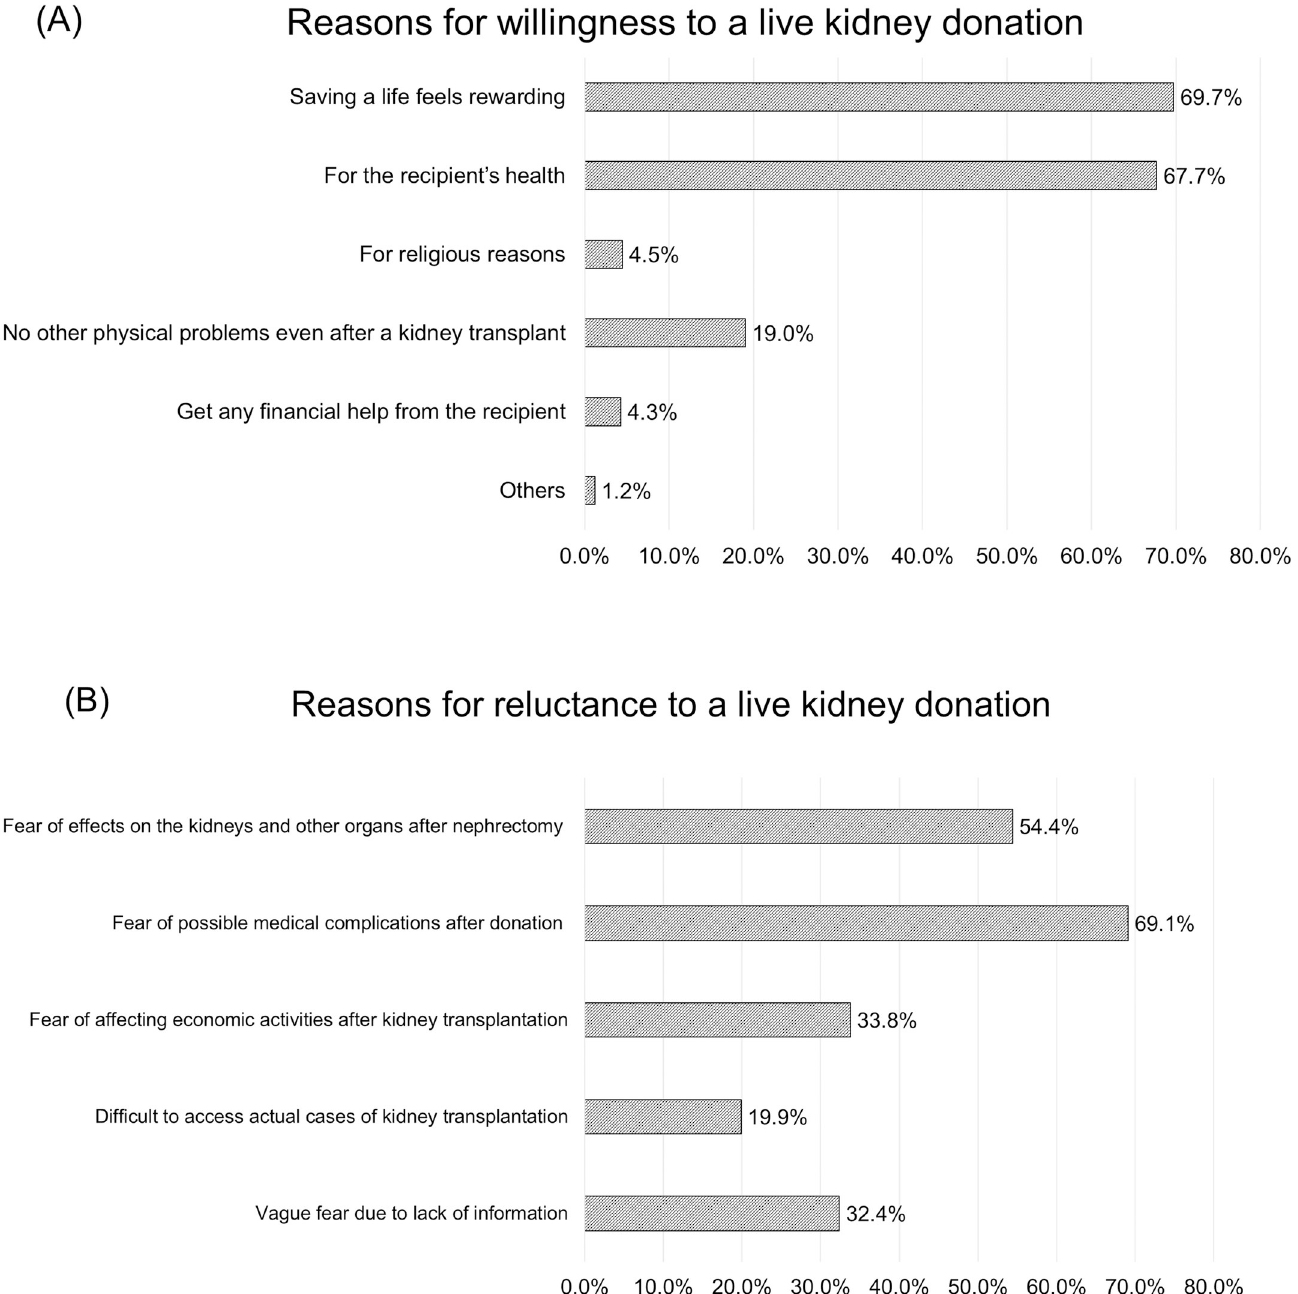
Fig 2. Reasons for not donating a kidney according to a living kidney donation or not. (A) Reasons for willingness to a live kidney donation. (B) Reasons for reluctance to a live kidney